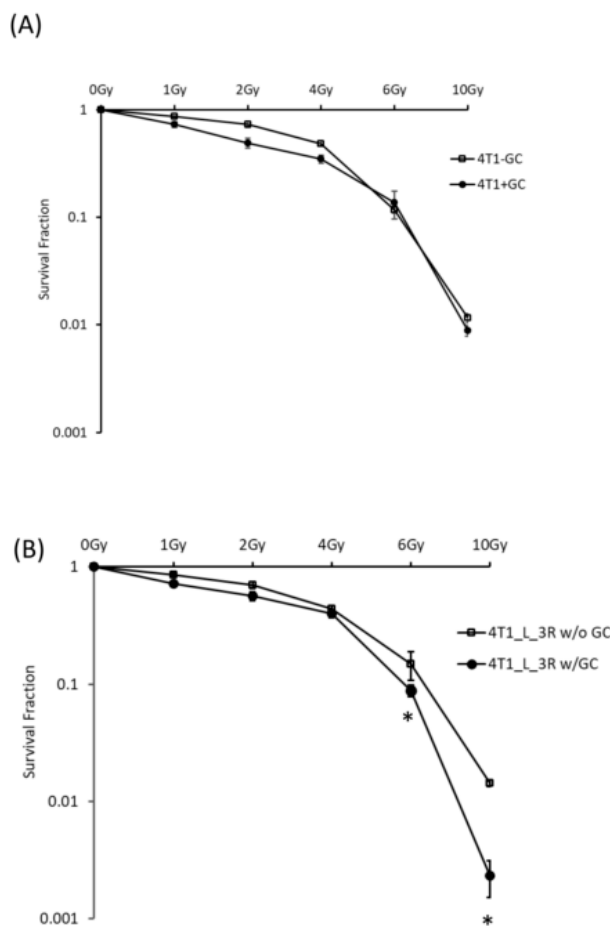
Figure 3. Analysis of survival fractions in cells exposed to X-rays with or without N -dihydrogalactochitosan (GC) pre-treatment. Cells were treated with 100 µ g / mL of GC for 24 h before irradiation at different doses. The colony formation assay was used to compare the survival curves of ( A ) 4T1 cells and ( B ) 4T1_L_3R cell; * p < 0.05.